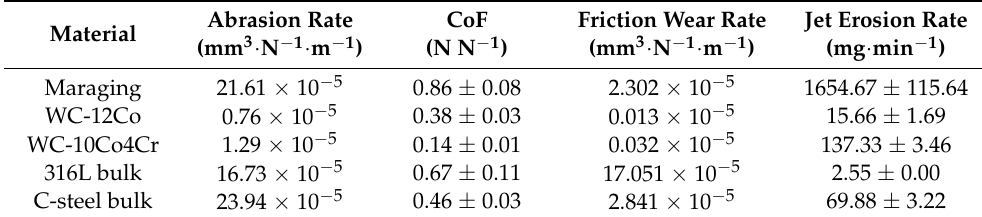
Table 4. Wear testing results.